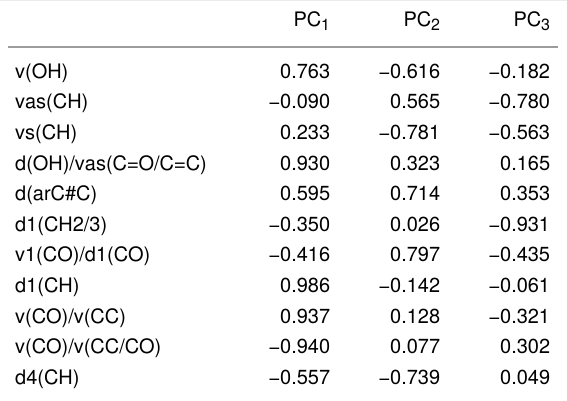
Table 1: Factor coordinates (principal components, PCs) of the vari- ables, based on correlations from the FTIR–PCA analysis of the flavonoid glycoside and flavonolignan antioxidants; only wavenumbers (“v” – for stretching vibrations, “d” – for bending vibrations) of the FTIR bands were used as input